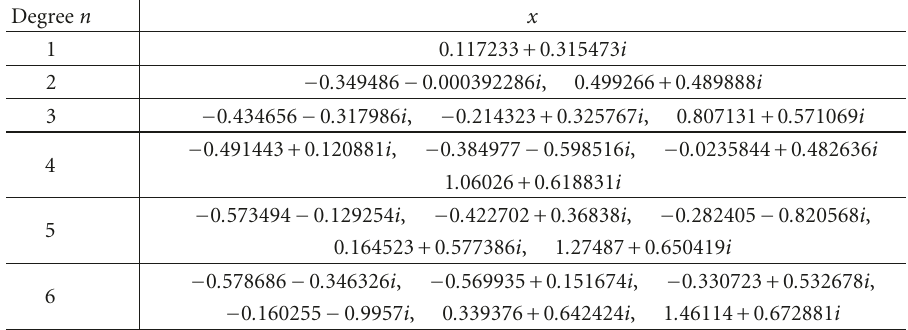
Table 4 . 3 . Approximate solutions of E n , q , w ( x ) = 0, w = e 2 πi/ 4